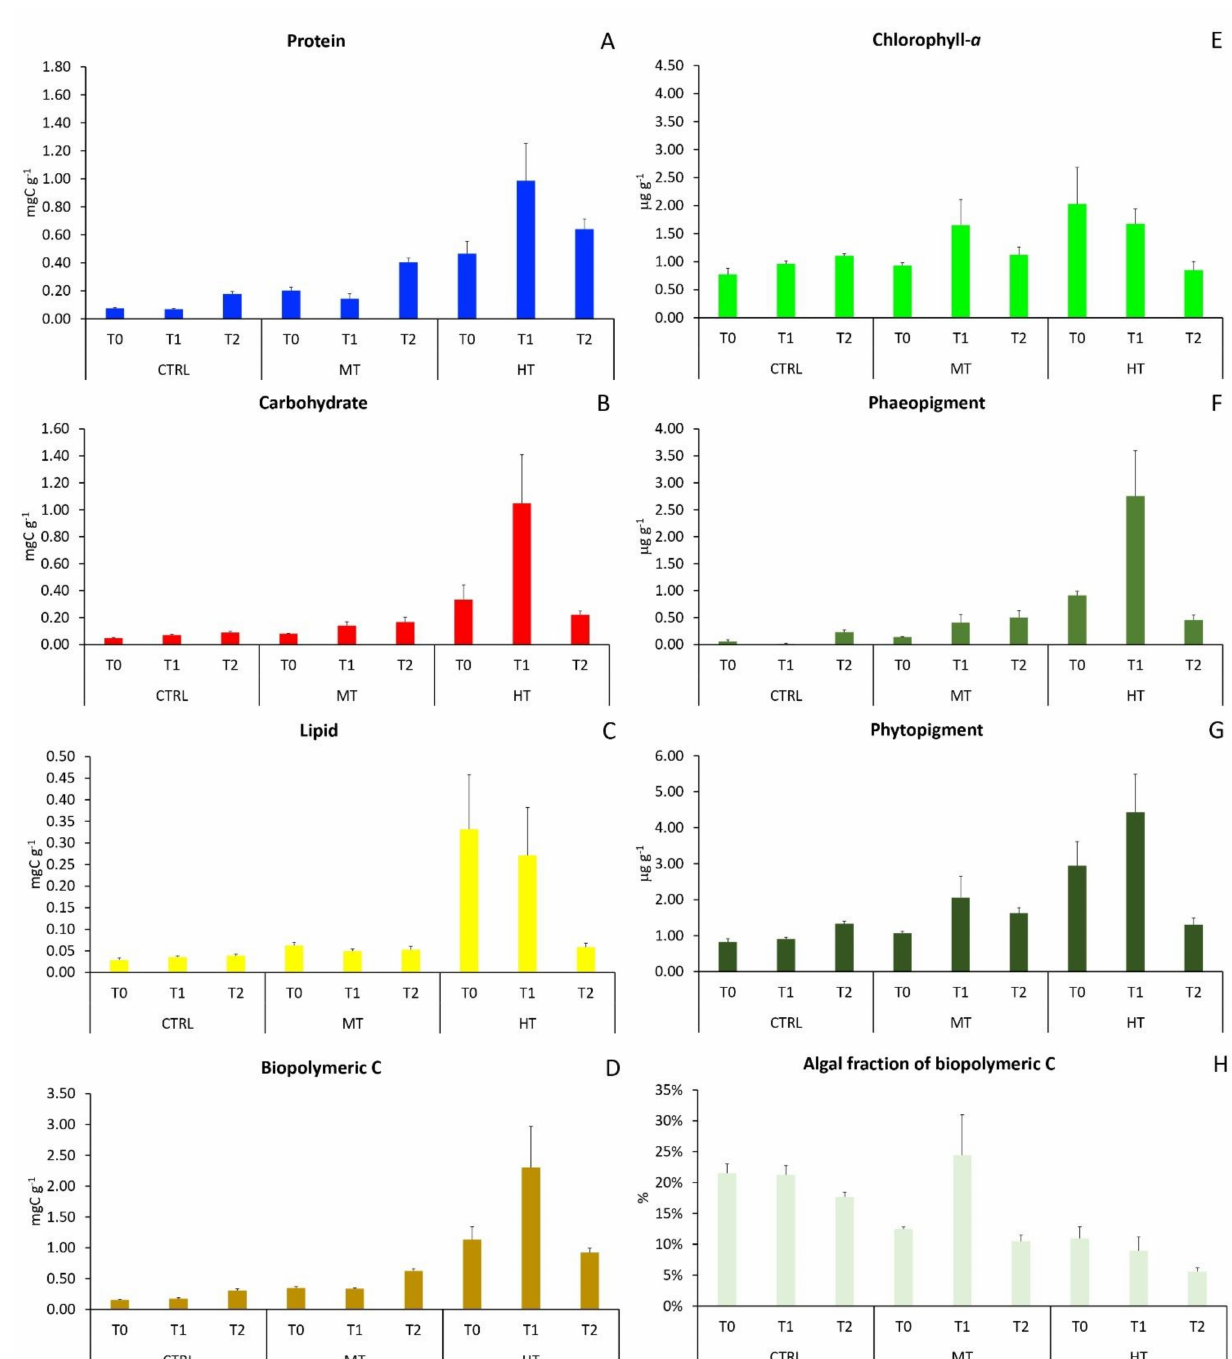
Figure 1. Changes in organic matter sedimentary contents in the three sampling sites at each sampling time: ( A ) protein, ( B ) carbohydrate, ( C ) lipid, ( D ) biopolymeric C, ( E ) chlorophyll-a, ( F ) phaeopigment, ( G ) total phytopigment, and ( H ) autotrophic fraction of biopolymeric C. CTRL = control; MT = medium temperature anomaly; HT = high temperature anomaly. T 0 = before PPW injection; T 1 = after 3 weeks from PPW injection; T 2 = after 11 weeks from PPW injection. Error bars are standard errors (n =